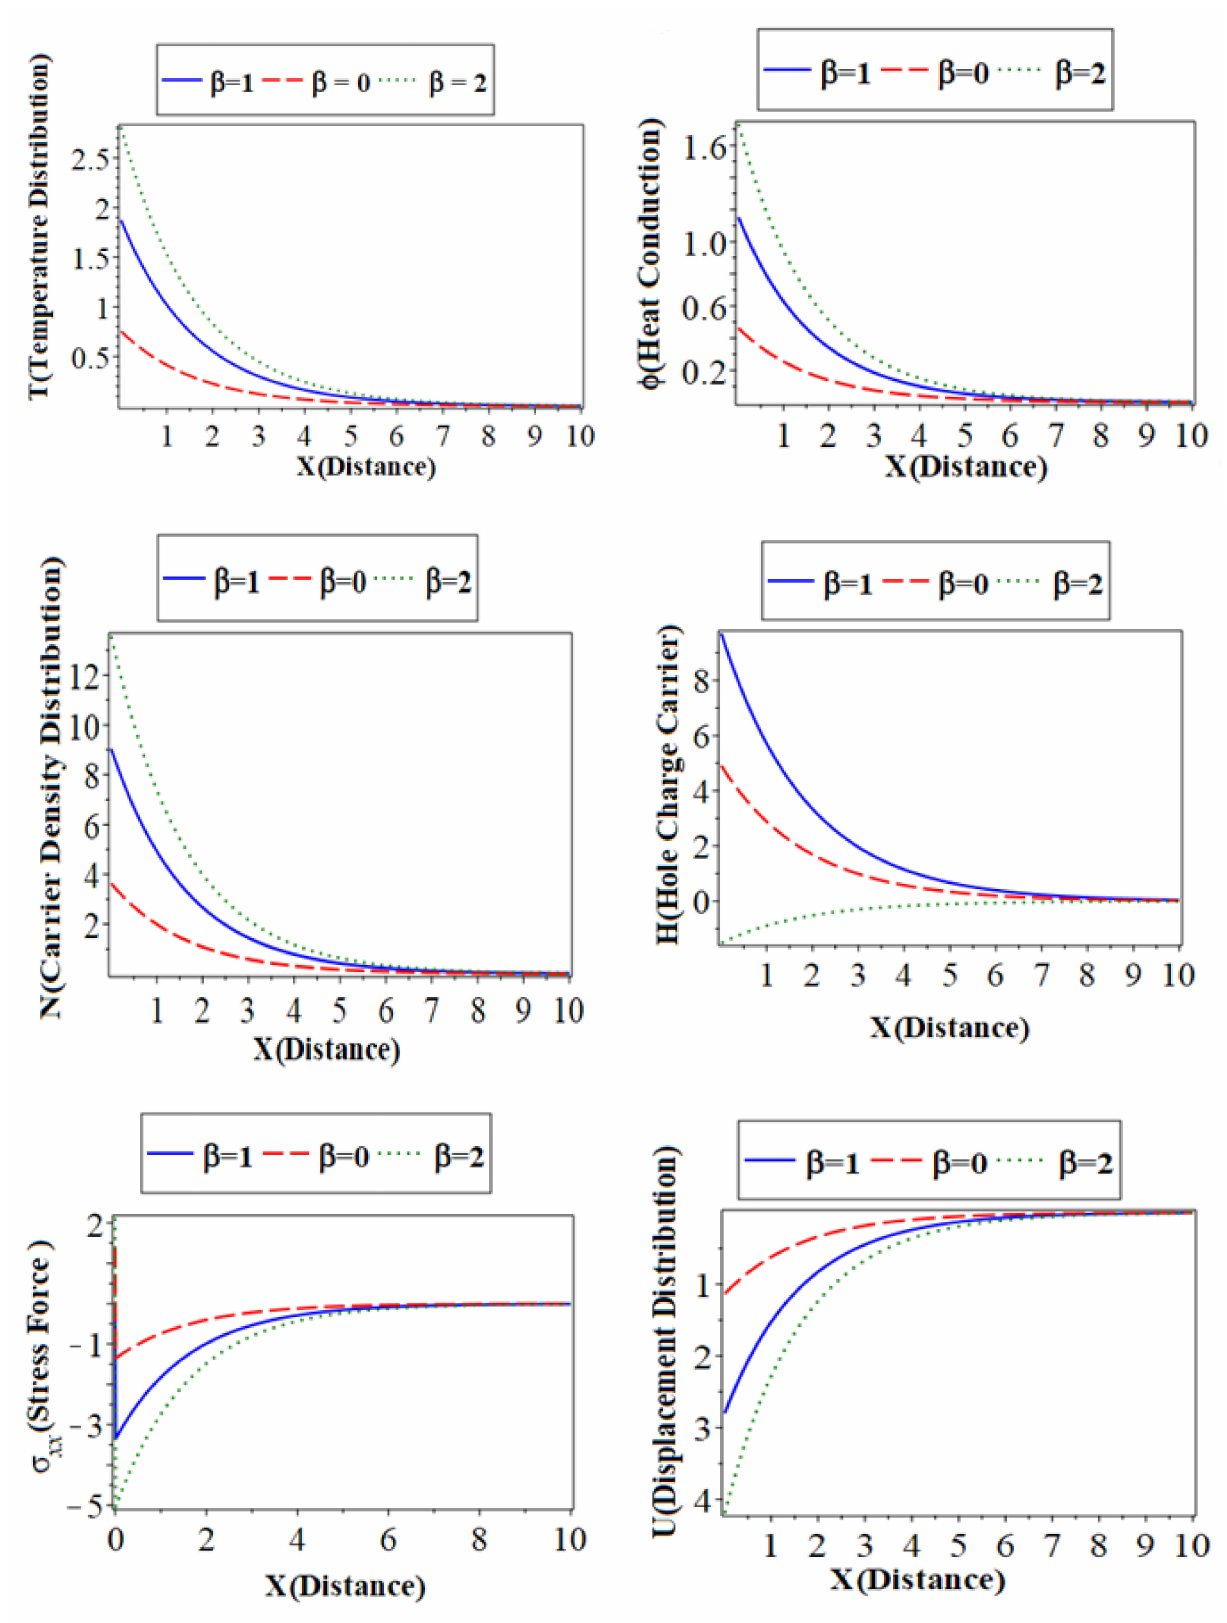
Figure 4. The variation of hyperbolic two-temperature of physical field distributions with distance when ε 1 = 0.001, τ θ = 0.02 and τ q =